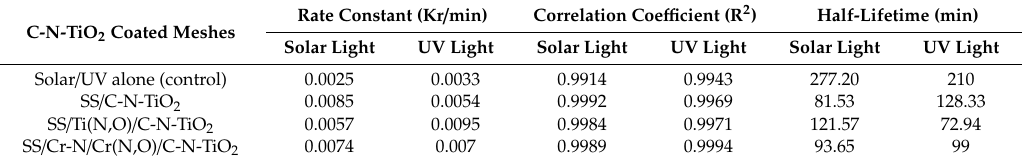
Table 3. Kinetic parameters for the decolouration of orange II dye at the following conditions: [O.II] 5 mg / L, pH 2.5, solution volume 500 mL, Solar simulator light (AM 1.5 radiation, 100 mW / cm 2 ) and Mega-Ray 160 W / 240 V MR160 UV lamp, and an irradiation time of 120 min. Rate Constant (Kr / min) Correlation Coe ffi cient (R 2 ) C-N-TiO 2 Coated Meshes Solar Light UV Light Solar Light UV Light Solar / UV alone